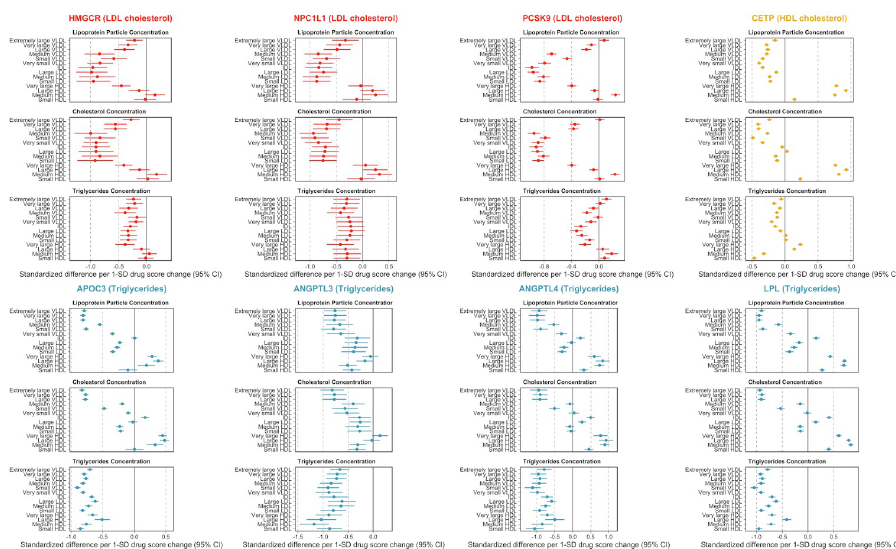
Fig 3. Forest plots illustrating the genetically predicted effects of lipid-modifying drug targets on measures of circulating metabolite concentrations using NMR in the UKB study. Effect estimates are based on an SD change in the genetically predicted drug target scores oriented to reflect therapeutic intervention (i.e., lower LDL cholesterol, lower triglycerides, and higher HDL cholesterol). Scores were derived using genetic variants robustly associated which lipoprotein lipid traits (as indicated in each target’s legend) at each encoding gene’s region. The data underlying this figure can be found in S7–S14 Tables . CETP, cholesteryl ester transfer protein; HDL, high-density lipoprotein; IDL, intermediate density lipoprotein; LDL, low-density lipoprotein; NMR, nuclear magnetic resonance; SD, standard deviation; UKB, UK Biobank; VLDL, very low-density lipoprotein.